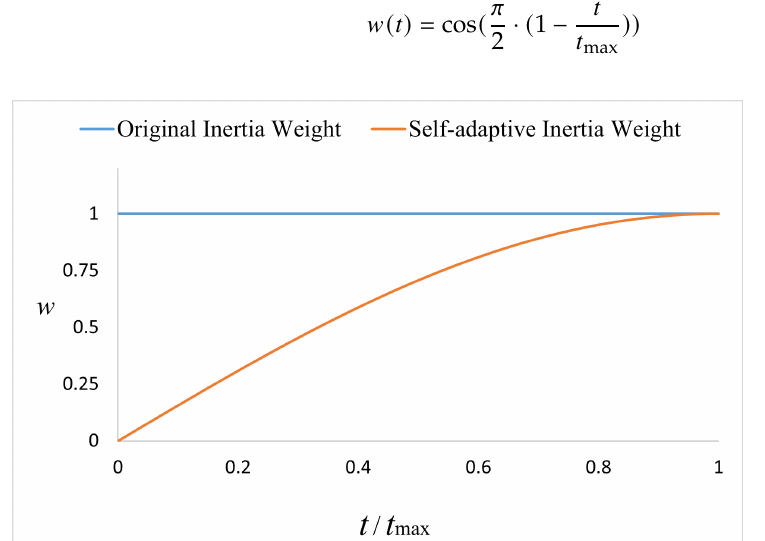
Figure 4. Self-adaptive inertia